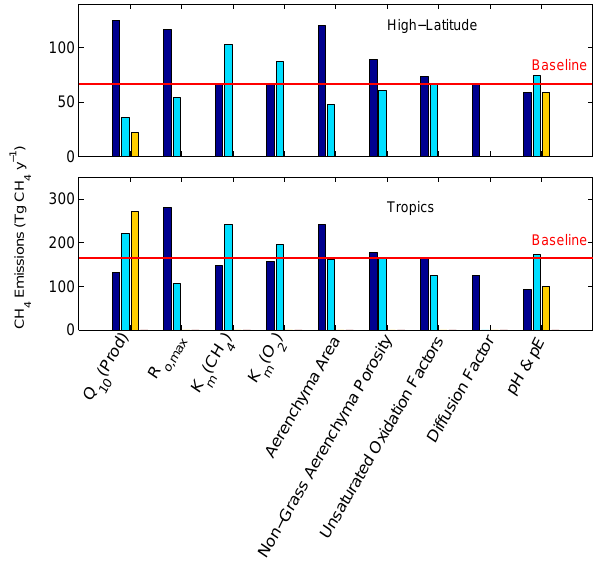
Fig. 9. Single value sensitivity analysis around the baseline set of values for Q 10 of production (1.5, 3, 4); inundated oxidation pa- rameters ( R o , max ) (1 . 25 × 10 − 6 , 1 . 25 × 10 − 4 ); K CH (5 × 10 − 4 , 4 5 × 10 − 2 ); K O (2 × 10 − 3 , 2 × 10 − 1 ); aerenchyma area (0.2, 2); 2 aerenchyma non-grass porosity (0.05, 0.15); unsaturated oxidation factors ( R o , max and K CH set to be the same as saturated values), 4 soil diffusivity (increase by a factor of 10), and pH and pE effects ( f pH and f pE applied, f pH and f pE set to 1, f pH applied and f pE set to 1). See Methods for description of parameter values